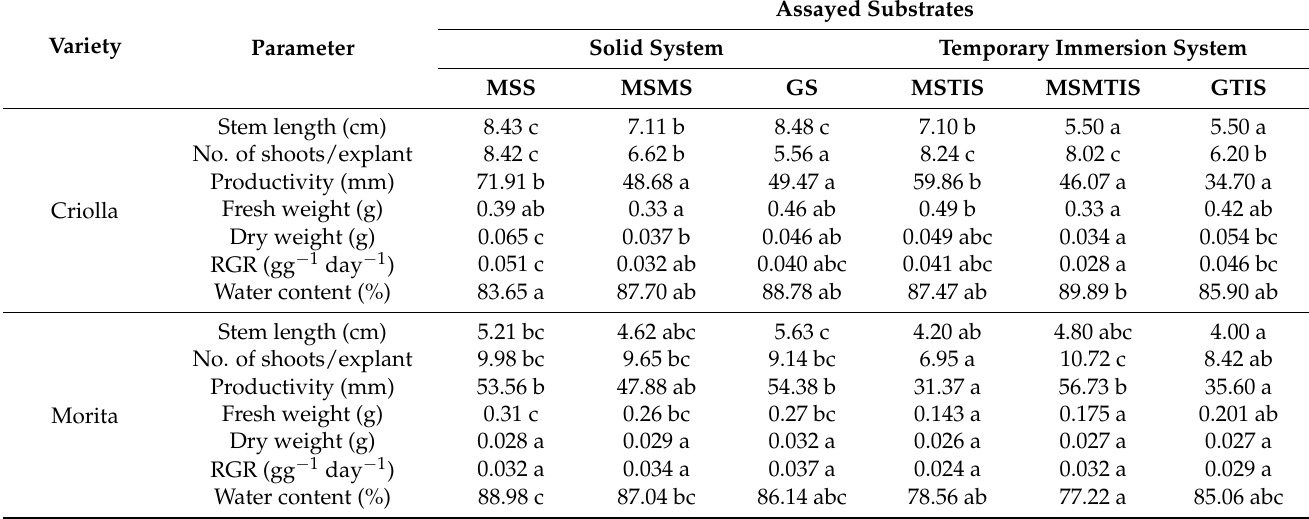
Table 1. Comparison of the average values of the biometric parameters obtained in the microprop- agation of the stevia varieties in the substrates assayed.